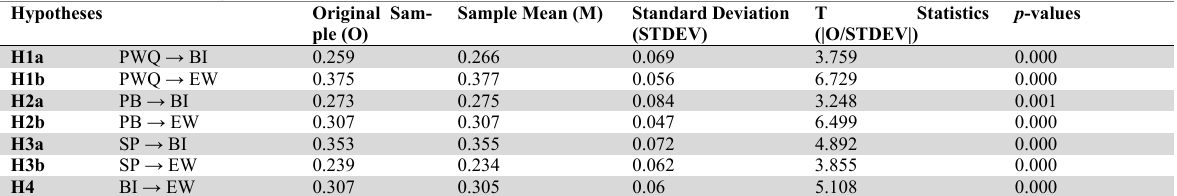
Path Coefficient and Significance Test Results